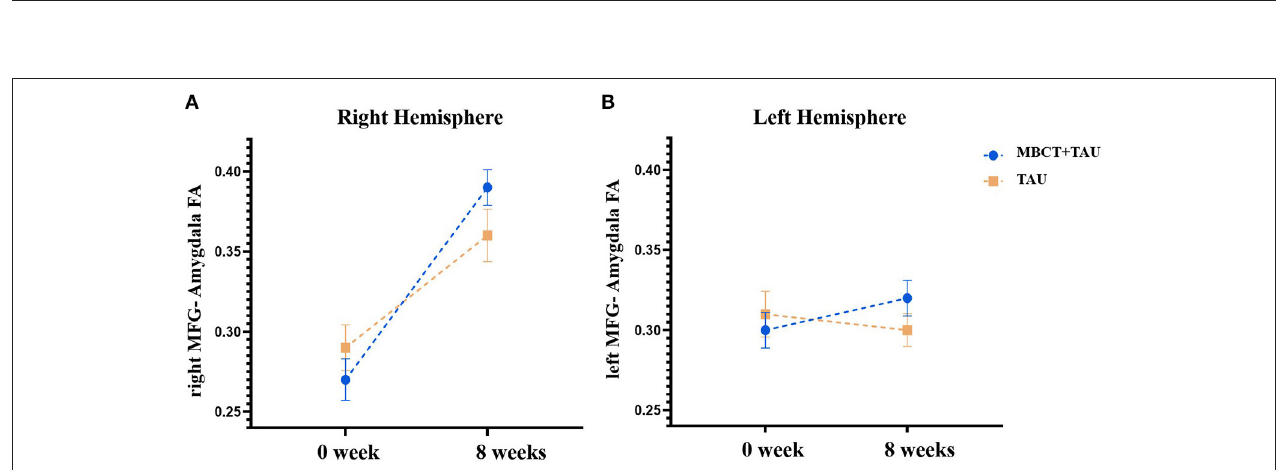
FIGURE 4 | Fractional anisotropy of the MFG-amygdala before and after therapy in the two groups. (A) Fractional anisotropy of the right MFG-amygdala before and after therapy in the two groups. (B) Fractional anisotropy of the left MFG-amygdala before and after therapy in the two groups.